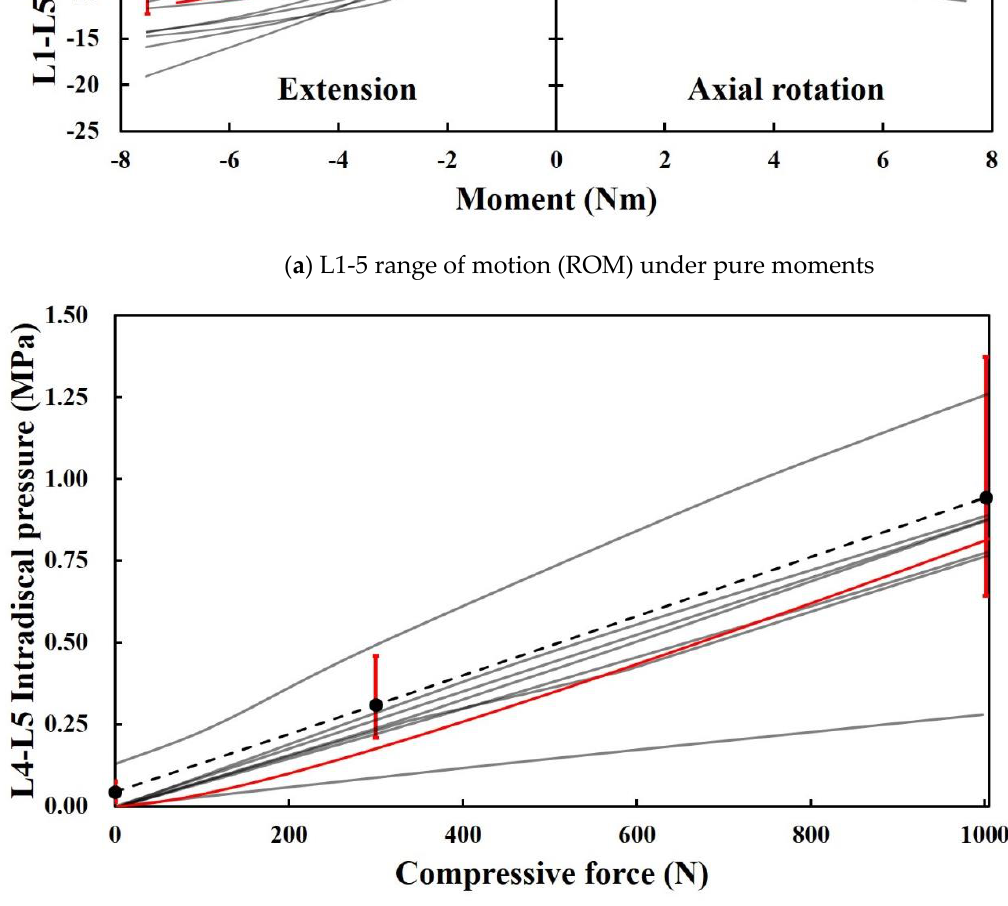
Figure 4. ROMs and intervertebral disc (IVD) pressure in the present study and extant study: ( a ) Data from eight previous studies and the present study on ROM with respect to motion. Black dotted lines represent the median curves of 10 L1-5 specimens [44,48]. The red ranges denote the range of results for a moment corresponding to 7.5 Nm. ( b ) Data from eight previous studies and present study on intradiscal pressure between L4 and L5 with respect to flexion. Black dotted line and red ranges denote the median relationship for 15 L4-5 segments, and its range of results for 0 N, 300 N, and 1000 N [44,49].